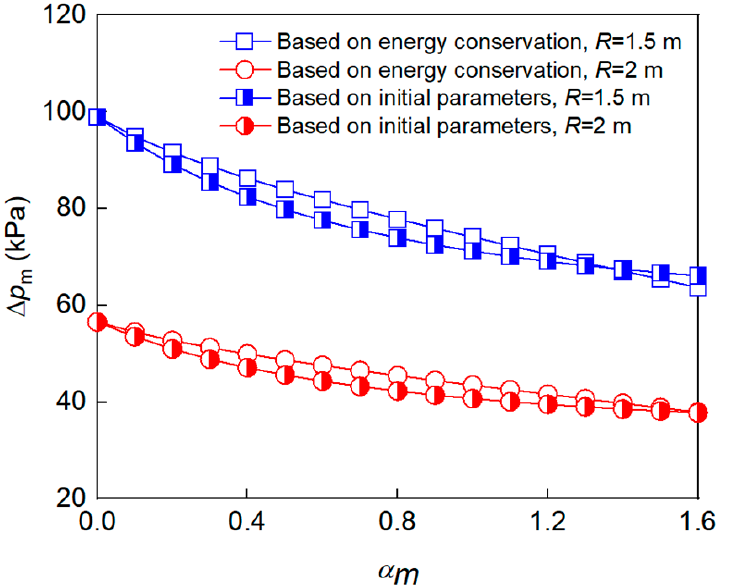
Figure 5. Calculations of peak overpressure for charges with different mass ratio.